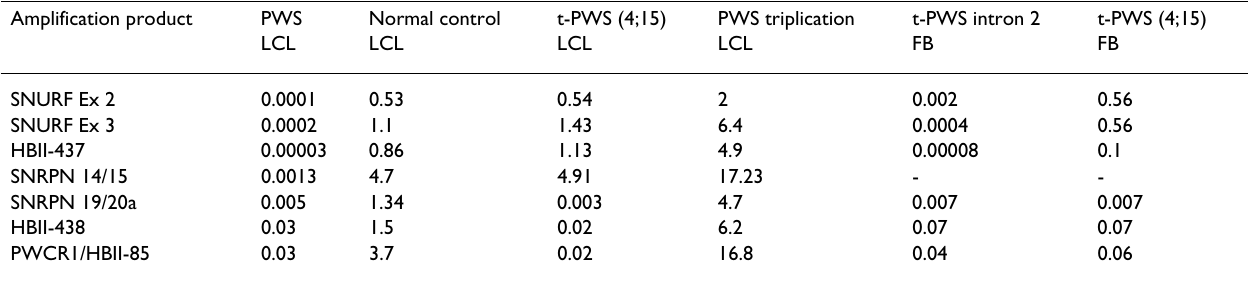
Table 2: SNRPN and snoRNA expression analysis with quantitative RT-PCR Amplification product PWS Normal control t-PWS